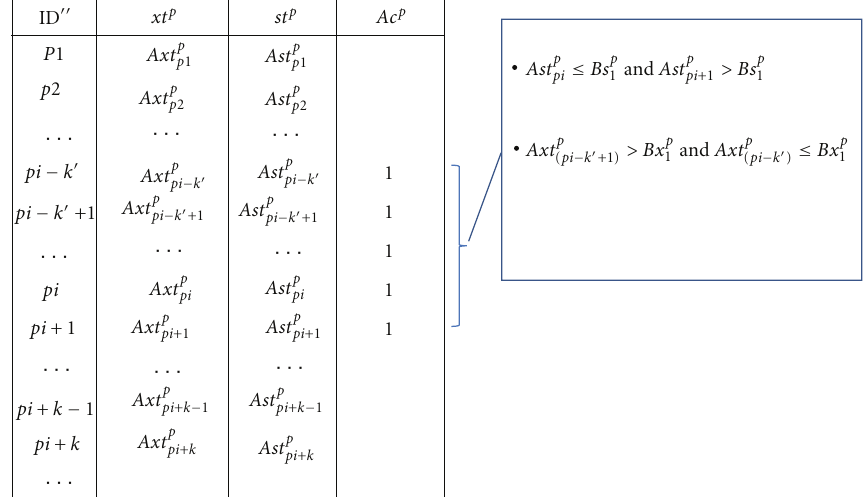
p Ac p ... , Ac p = 1 } . pi = 1, pi +1 = 1, pi + k